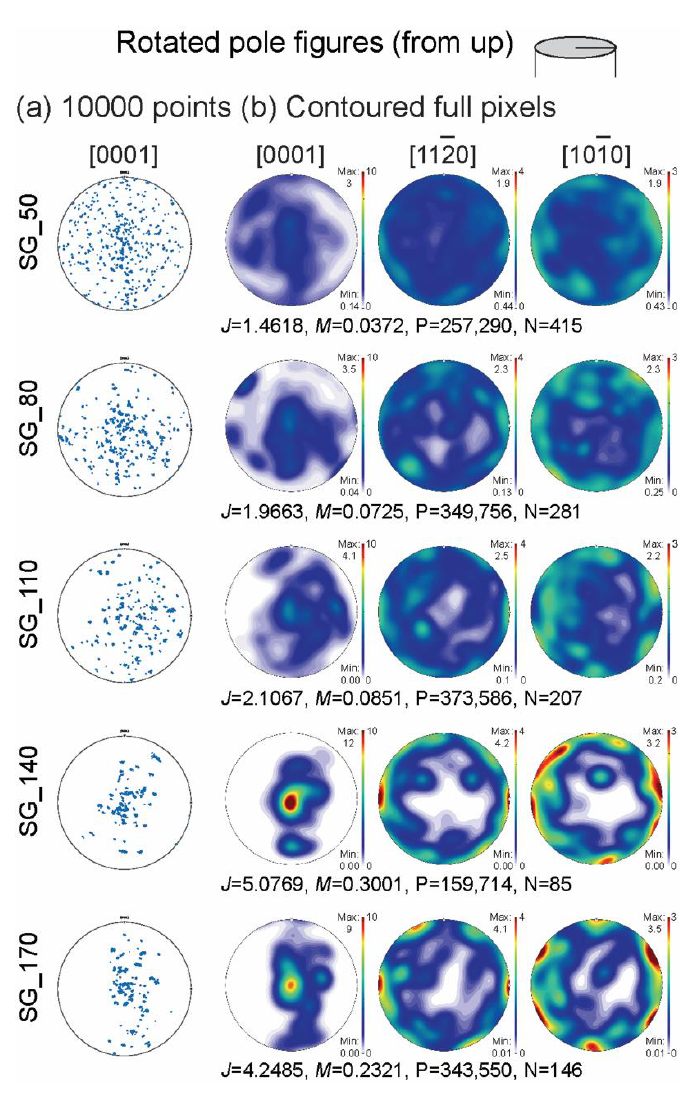
Figure 6. Rotated crystallographic preferred orientations of the ice samples using ( a ) 2000 random points and ( b ) full pixels data. The small cylinder at the top right shows the orientation of the plotted pole figures. The crystallographic data are plotted using the MATLAB-based toolbox MTEX as poles on upper-hemisphere equal-area projections with contours in multiples of uniform distribution. P = Number of pixels; J = J -index; M = M -index; N = Number of grains.